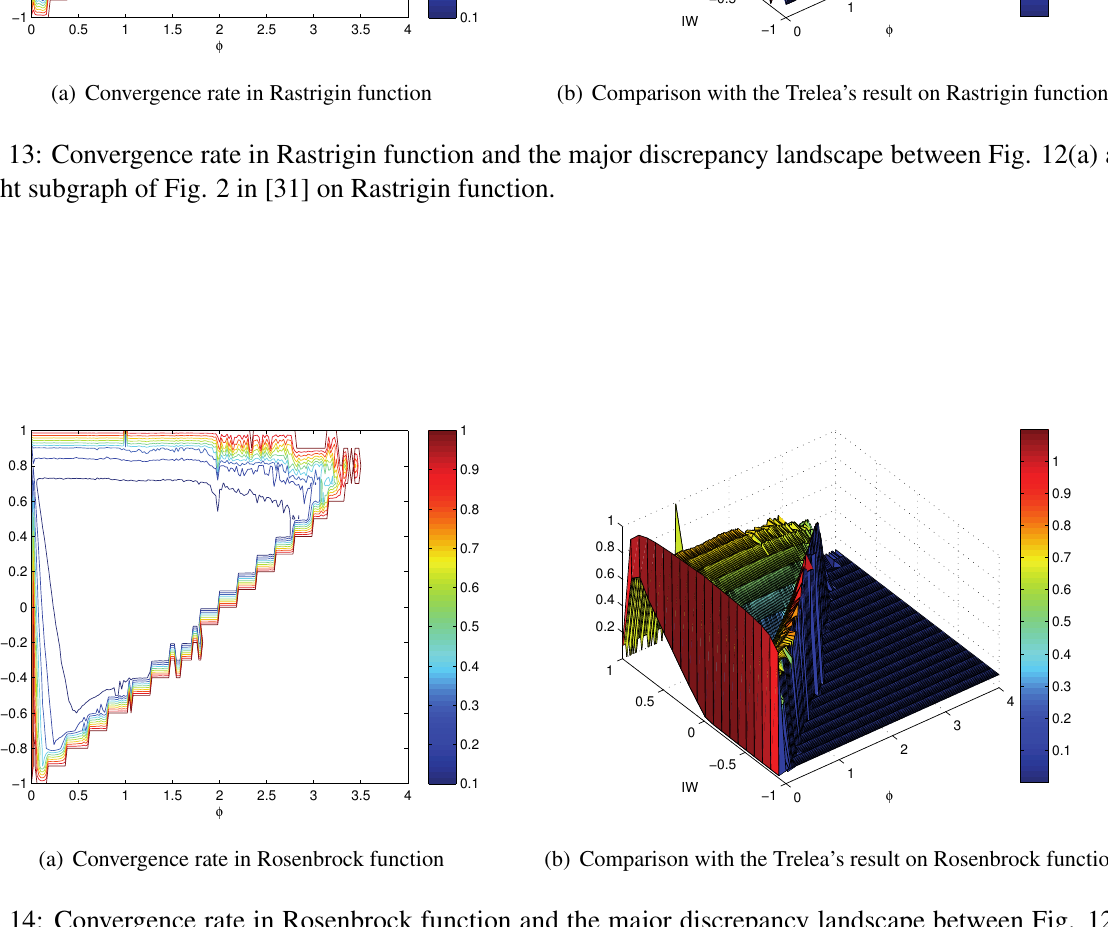
Figure 14: Convergence rate in Rosenbrock function and the major discrepancy landscape between Fig. 12(a) and the right subgraph of Fig. 2 in [31] on Rosenbrock